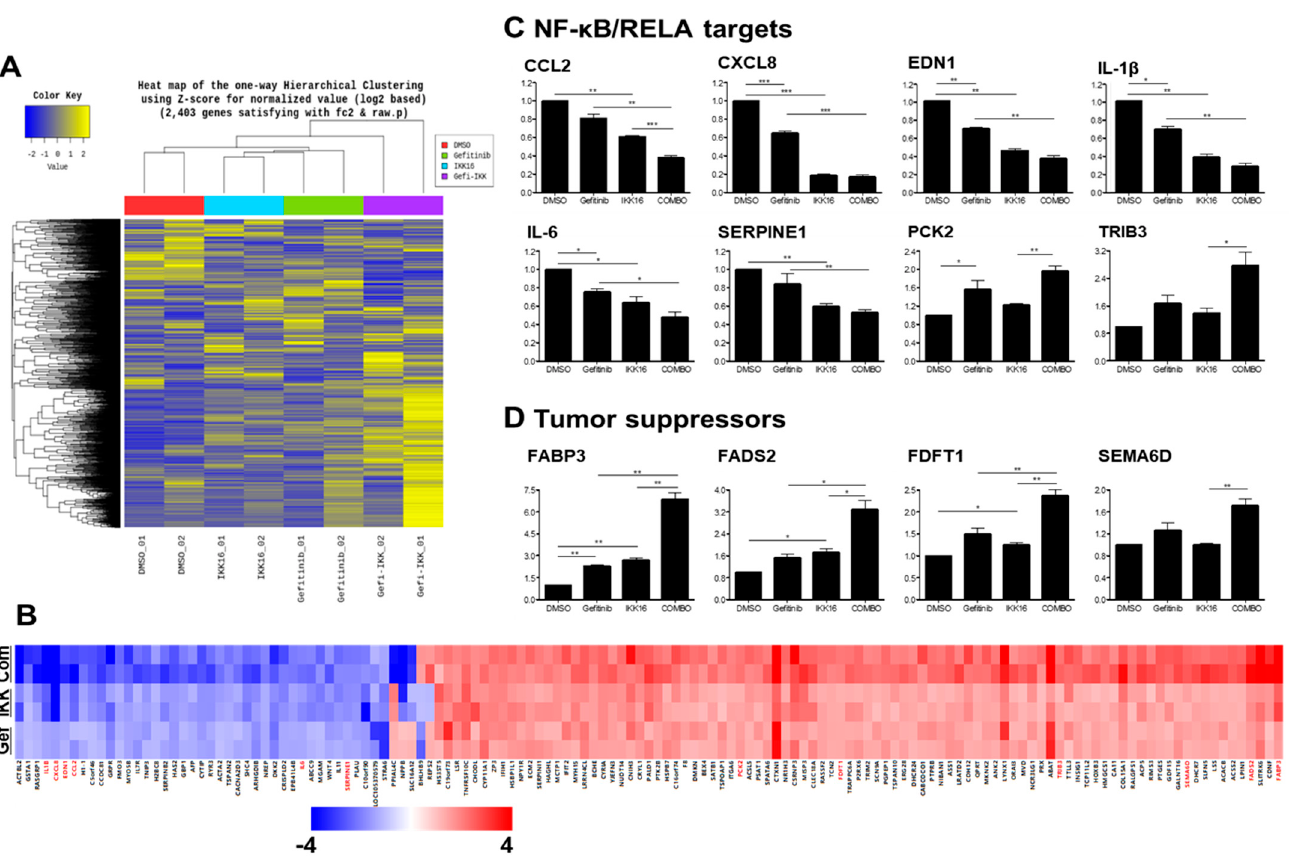
Figure 6. Global transcriptional changes induced by the Gefitinib+IKK16 treatment. ( A ) Heat map of a total of 2403 genes identified that showed at least 2-fold change upon the gefitinib+IKK16 treatment in duplicated samples. ( B ) Heat map of 139 genes whose mRNA levels were reproducibly modulated by the gefitinib+IKK16 combination ( ≤ mean ± 0.15). qRT-PCR results for ( C ) NF- κ B/RELA target genes and ( D ) tumor suppressor genes in MDA-MB-231 cells treated with drugs for 24 h as indicated. Data from three independent experiments are shown as the mean ± SEM. *, p < 0.05; **, p < 0.01; ***, p <